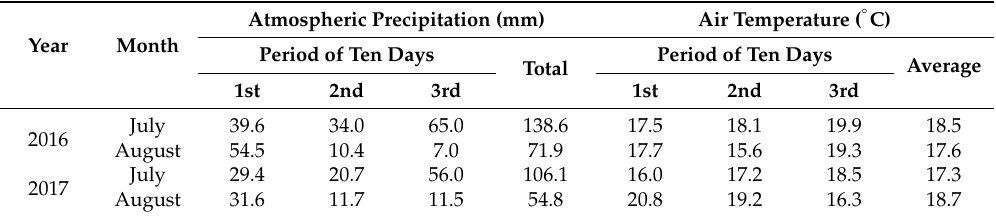
Table 3. Atmospheric precipitation and air temperature during the study period according to the Meteorological Station in Bałcyny, Poland.